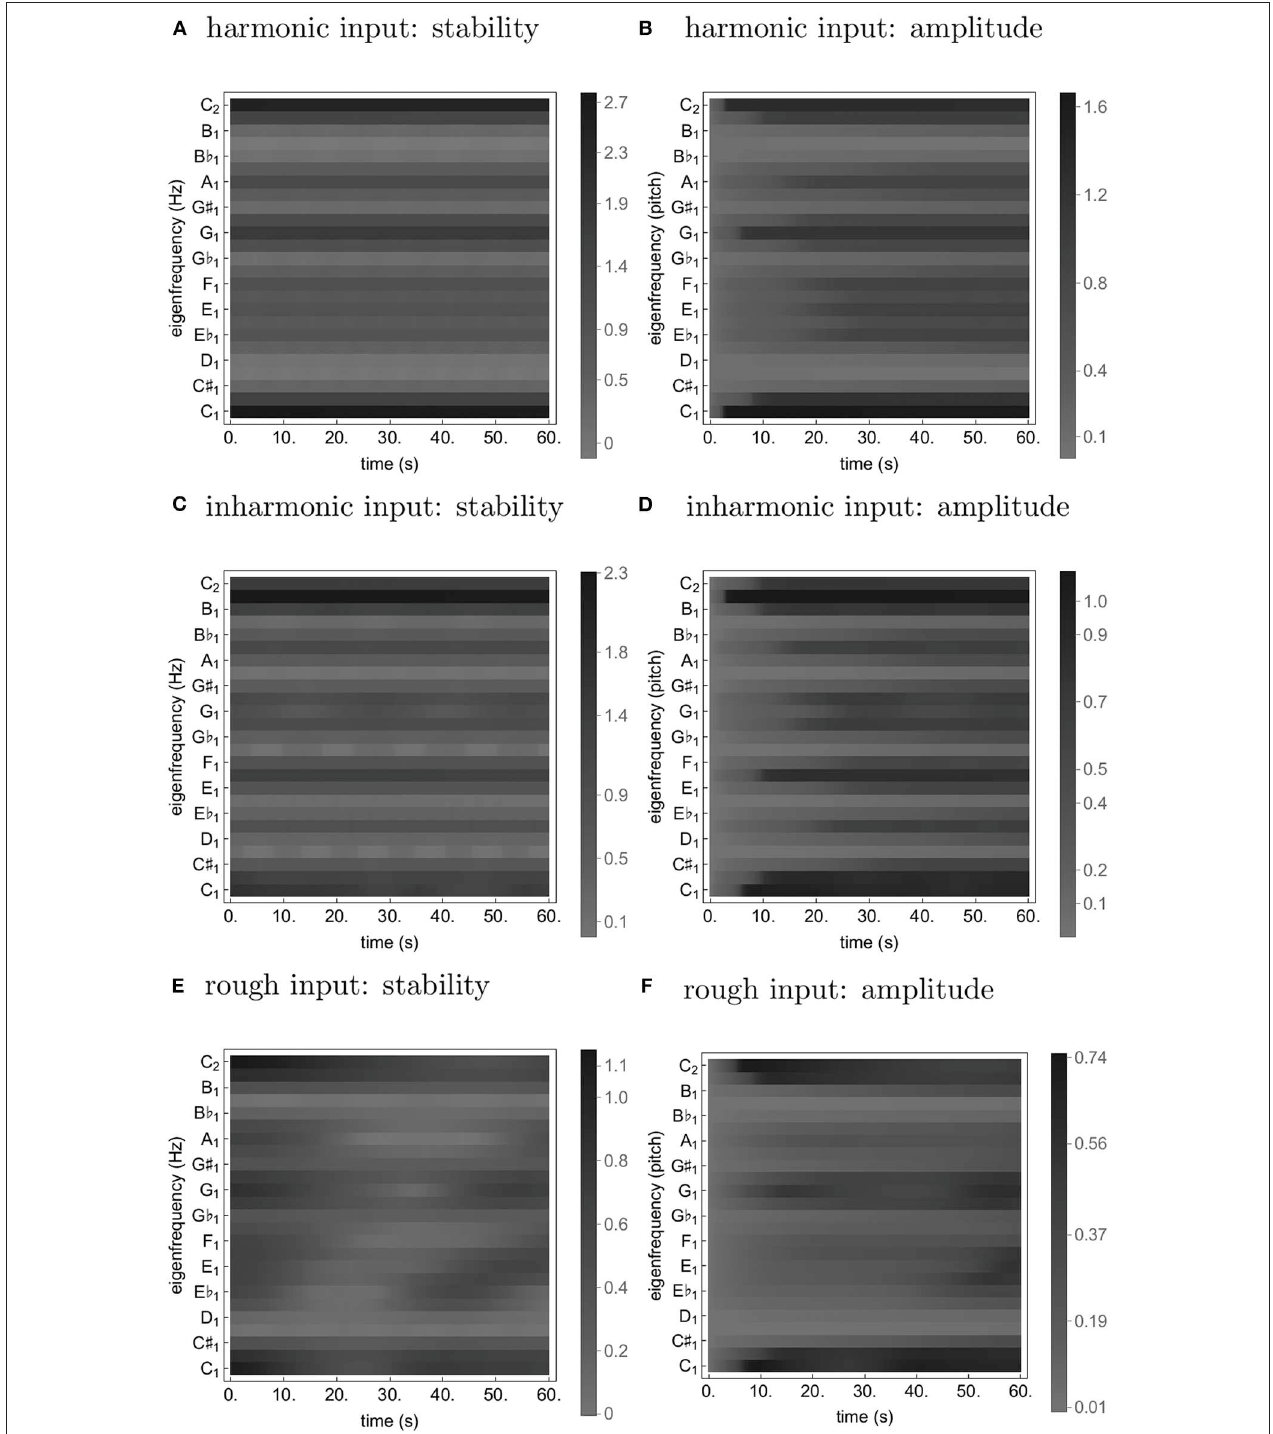
FIGURE 1 | Time traces from simulations of Equation (24) with a soft harmonic (A,B) , inharmonic (C,D) , and rough (E,F) input. The stability (A,C,E) is quantified as ( J ) [0,0] (see Equation 2); the amplitude (B,D,F) is simply ℜ (cid:0) (cid:1)